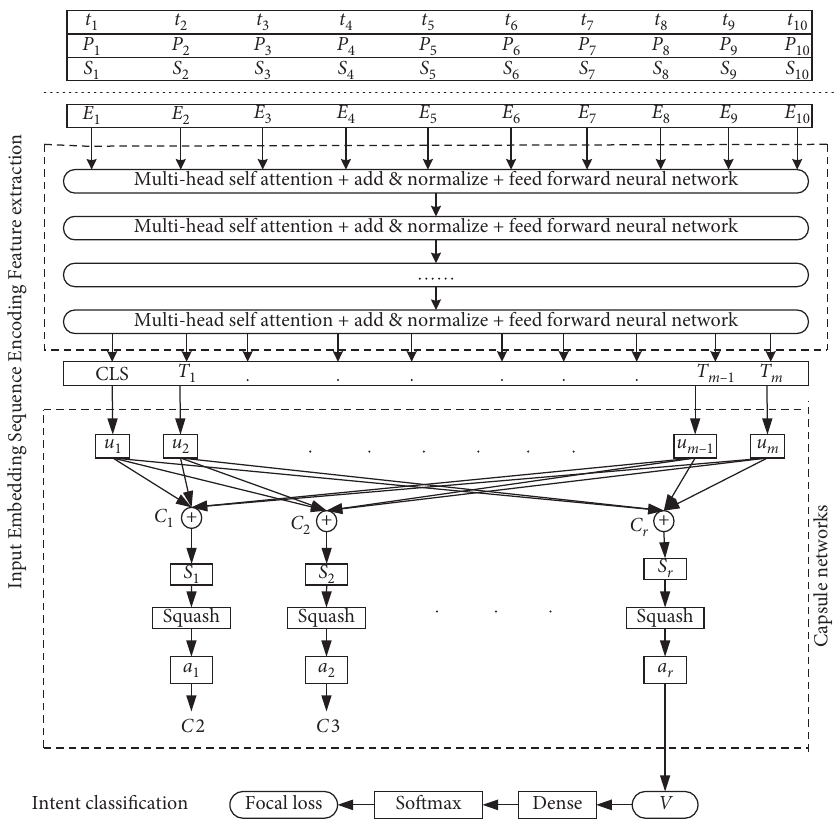
Figure 1: The architecture of our BERT-Cap